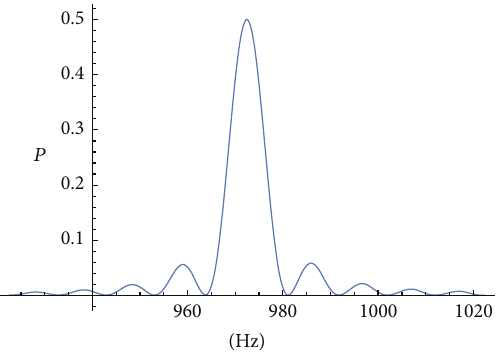
Figure 8: The transition probability as a function of the magnetic field frequency for the transition from the ground state to 6 th gravitational